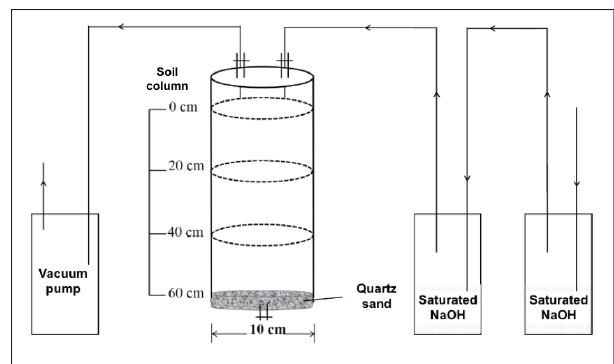
Figure 1. Design of the soil column experiment for monitoring soil respiration and leaching after simulated extreme precipitation events